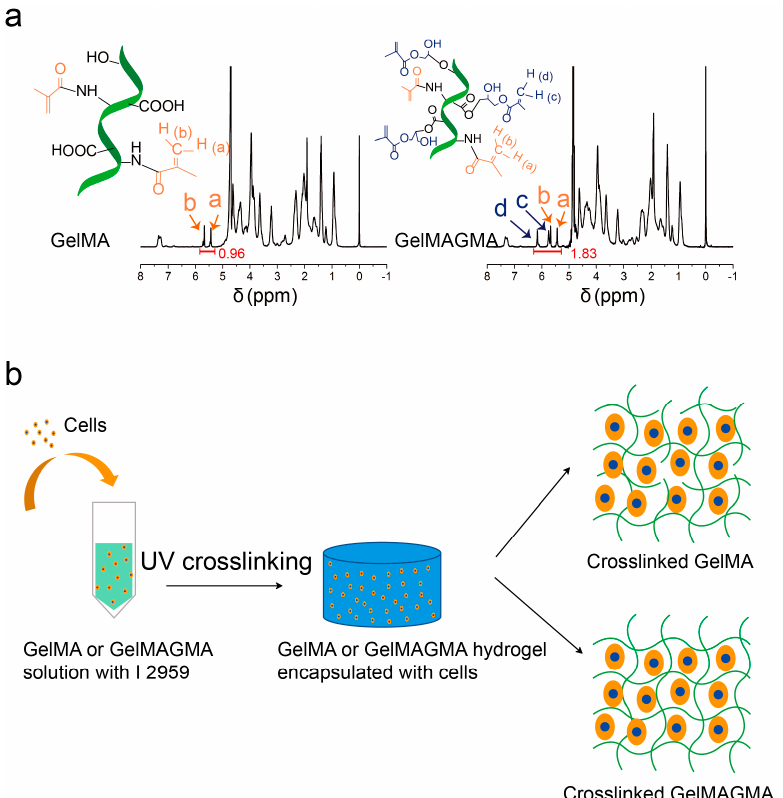
Figure 1. 1 H NMR spectra of GelMA and GelMAGMA macromers ( a ). Experimental scheme of GelMA and GelMAGMA hydrogels encapsulated with chondrocytes and illustration of cell-laden hydrogel networks ( b ).